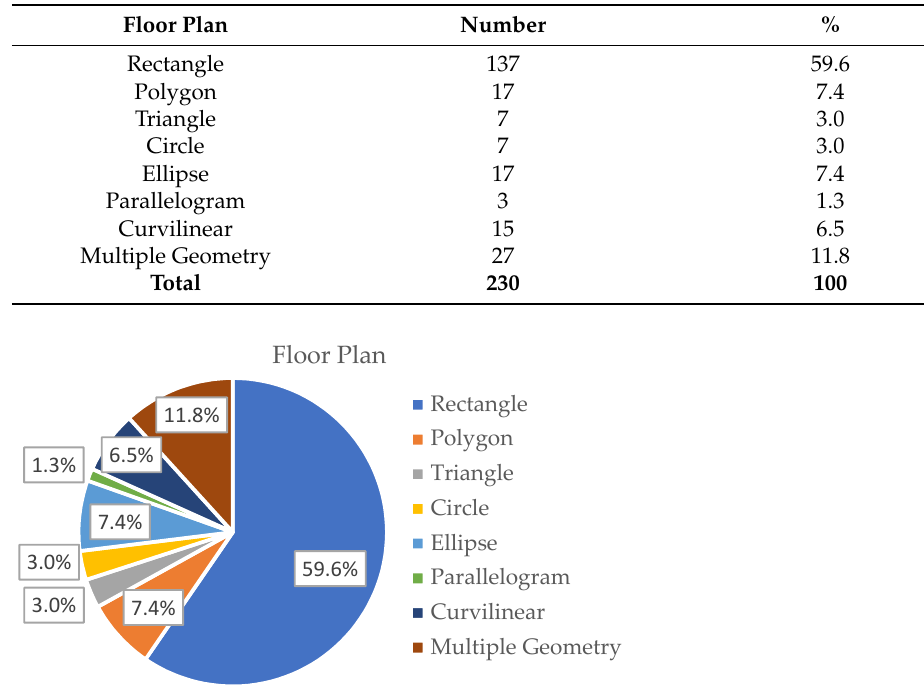
Figure 7. Floor plan classification for tall buildings. Table 4. Classification of selected tall buildings by floor plan.